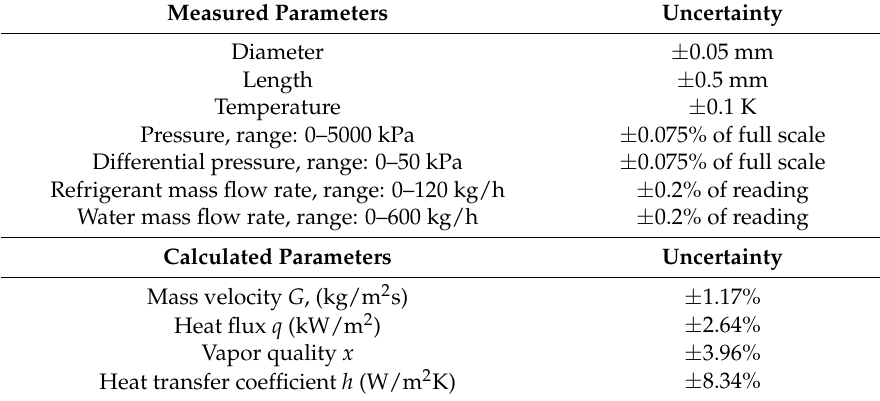
Table 5. Uncertainties of measured and calculated